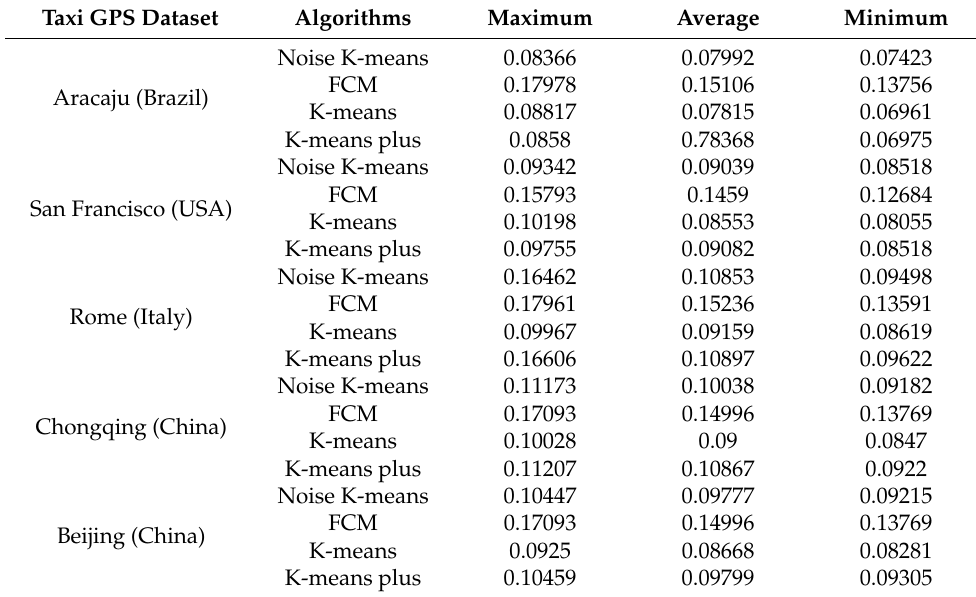
Table 5. Comparison results of DB index evaluation values. Taxi GPS